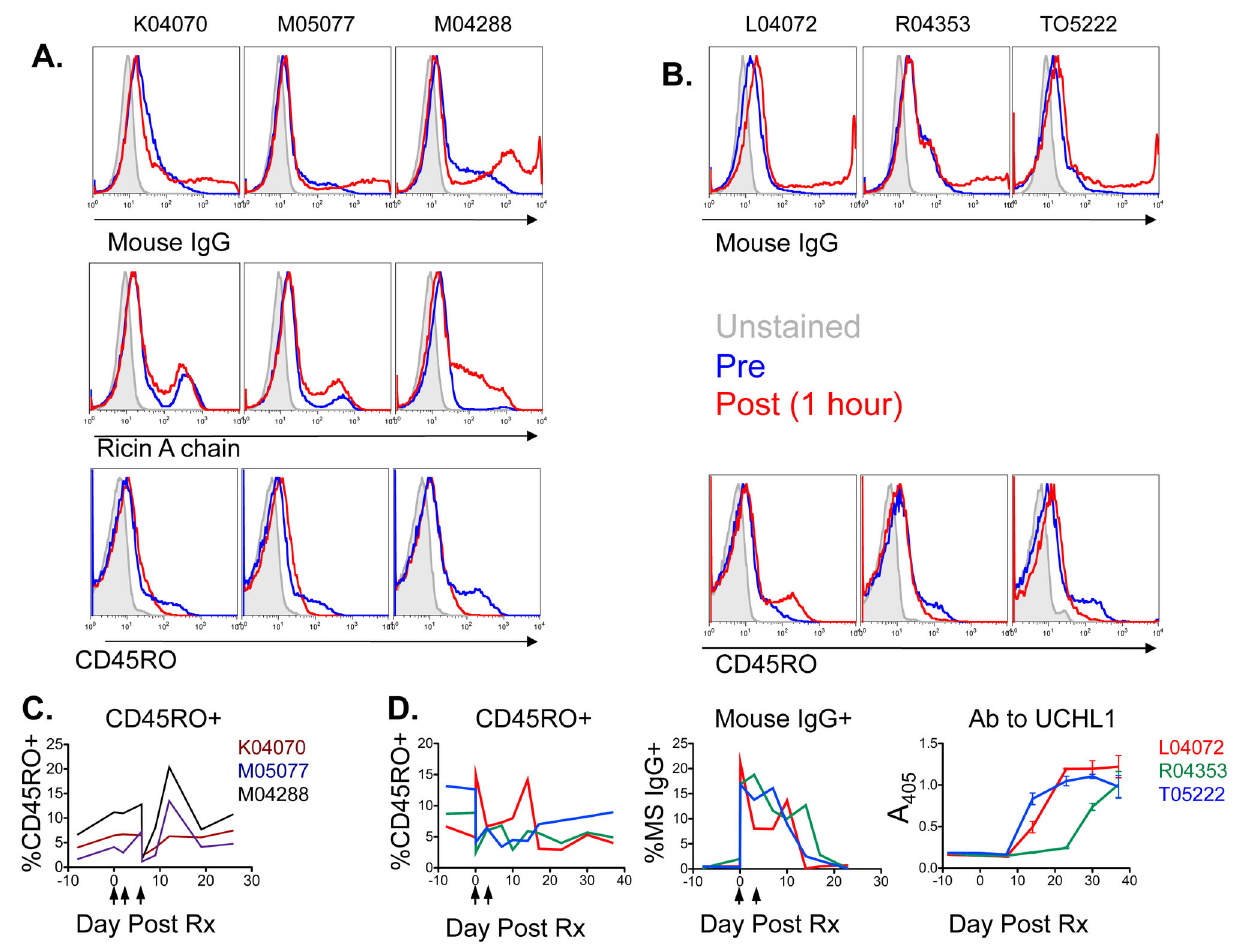
Figure 10. In vivo administration of UCHL1 immunotoxin or mAb. Groups of three aviremic SHIV-infected macaques each received escalating doses of UCHL1-ricin A chain immunotoxin (panels A and C) or UCHL1 mAb (panels B and D). A . Flow cytometry was performed prior to (blue histograms) and 1hr following (red) administration of the third dose of UCHL1-ricin A chain immunotoxin. Cells were stained with antibody specific for mouse IgG (top), ricin A chain (middle), or CD45RO (bottom). B . Flow cytometry was performed prior to and one hour following the first administration of UCHL1 mAb. Cells were stained with antibody specific for mouse IgG (top) or CD45RO (bottom). C . Percent of CD3+ cells that express CD45RO was followed with time using flow cytometry. Day 0 indicates the start of immunotoxin administration (vertical arrows). D . The effects of administering UCHL1 mAb were followed over time. Day 0 indicates the start of mAb administration (vertical arrows). Left: percent of CD3+ cells that express CD45RO, measured by flow cytometry. Middle: percent of cells detected with fluorescent anti-mouse IgG, measured by flow cytometry. Right: macaque anti-UCHL1 antibody measured by